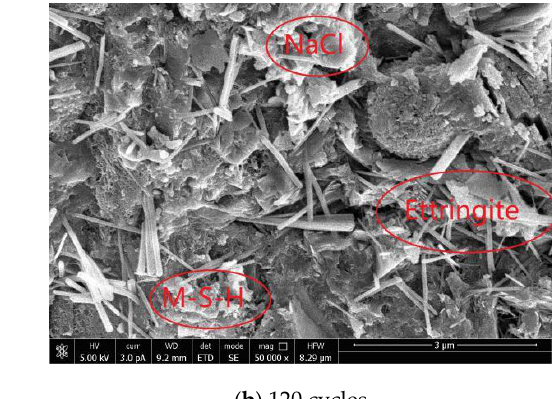
( b ) 120 cycles Figure 22. Microscopic morphology of MK concrete eroded by MgSO 4 solution. Figure 23 shows the micro-morphology of MK concrete when suffering corrosion of MgSO4 + NaCl complex solution. It can be seen from Figure 23a that there was a small number of pores inside the concrete, in which, the ettringites were inserted. The ettringite was featured in a small amount and needle-shaped. When the dry-wet alternation reached 120 cycles, it showed that the ettringite started to expand and was disorderly inlaid in the concrete block accompanied by a small amount of NaCl crystals and M-S-H. However, the ettringite volume was smaller than the expansion volume of the concrete block in the Na 2 SO 4 solution. The possible reason for this may be that the Mg(OH) 2 volume with small solubility at this time was already big enough. Additionally, the generation of NaCl crys-